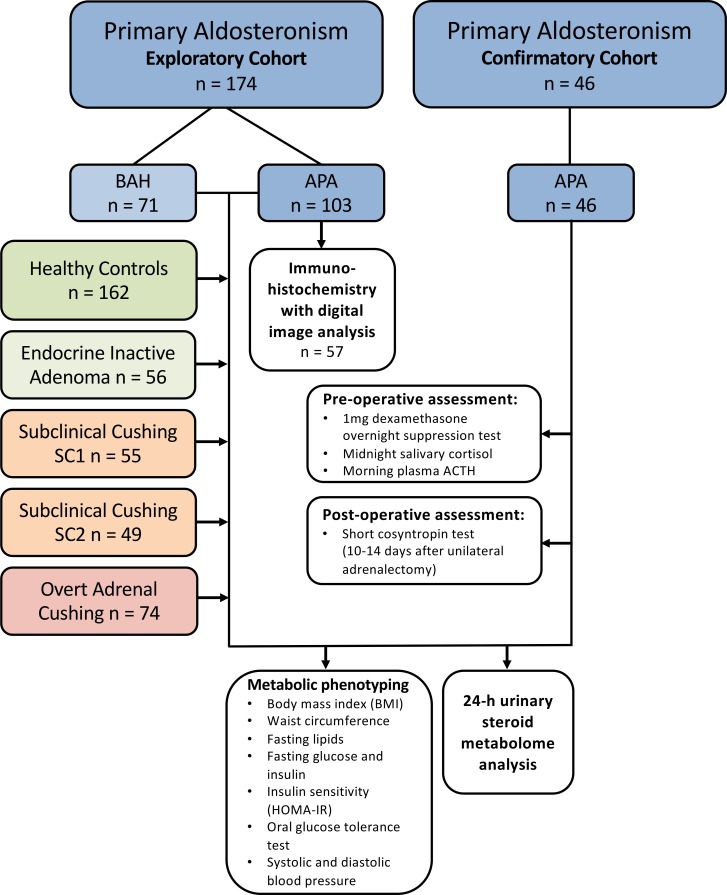
CONSORT diagram visualizing the included patient and comparator groups and the performed diagnostic work-up.After analysis of the results from the exploratory cohort, 46 patients were prospectively recruited with consecutive enrollment into the confirmatory cohort that underwent additional pre-and postoperative assessment of cortisol production. APA, unilateral aldosterone-producing adenoma; ACTH, adrenocorticotropic hormone; BAH, bilateral adrenal hyperplasia; HOMA-IR, homeostasis model assessment of insulin resistance.